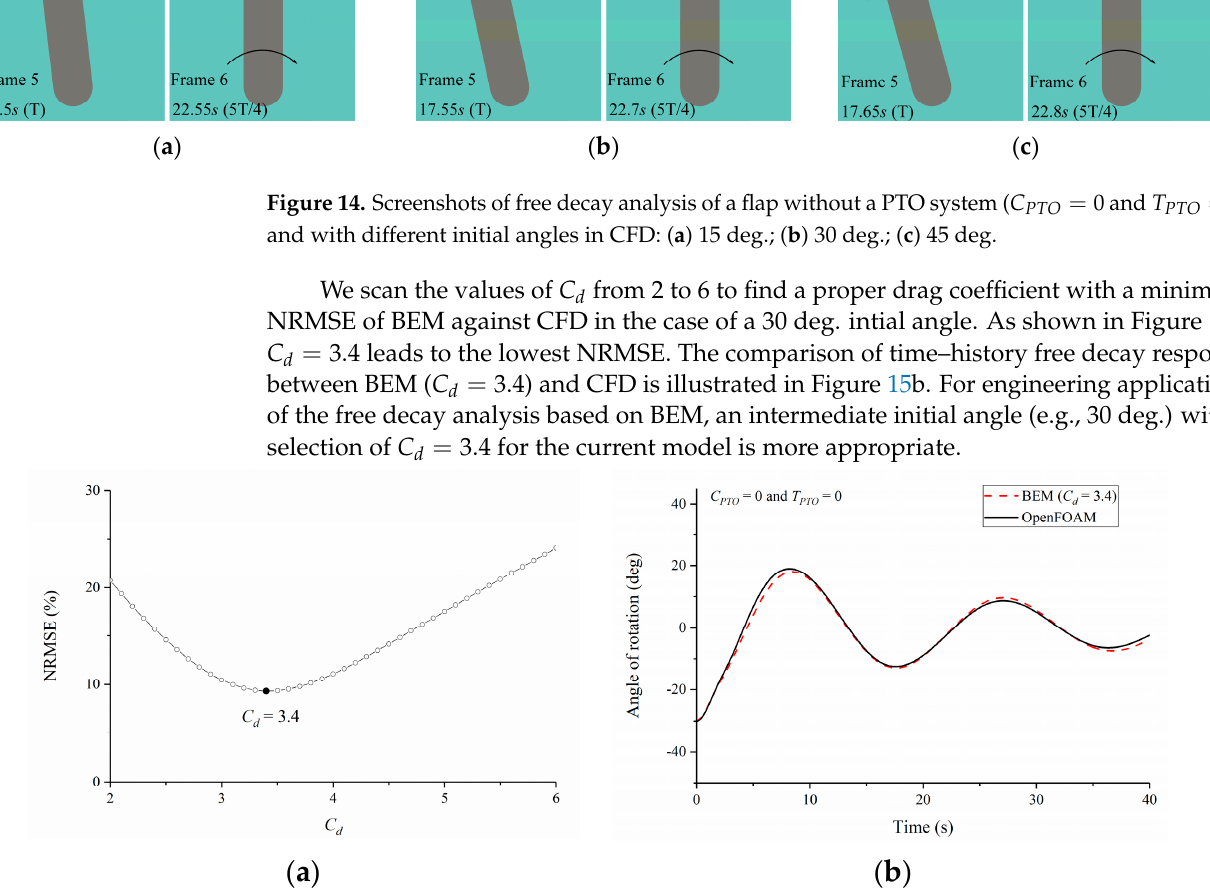
Figure 15. The results in the case of a 30 deg. intial angle: ( a ) NRMSE of BEM against CFD vs. C d ;